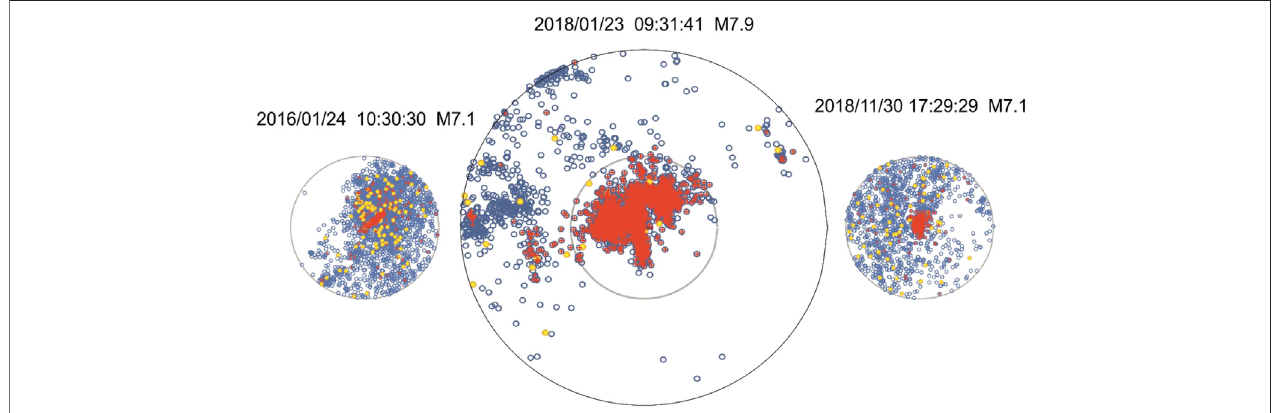
FIGURE5| Epicentersofthe M ≥ 2.5 earthquakes at angular distance of1 ° and 2.5 ° from theepicenterofeach ofthethree major earthquakesin SouthernAlaska. Note:openbluecirclesareepicentersofearthquakesinJanuary24,2006 – January24,2019,January23,2008 – May27,2019,andNovember30,2008 – May27,2019, correspondingly;yellowcircles andsmall redcrossesarethoseeventsoccurringwithin128days beforeand 128days aftertheorigintimeofamajorevent,